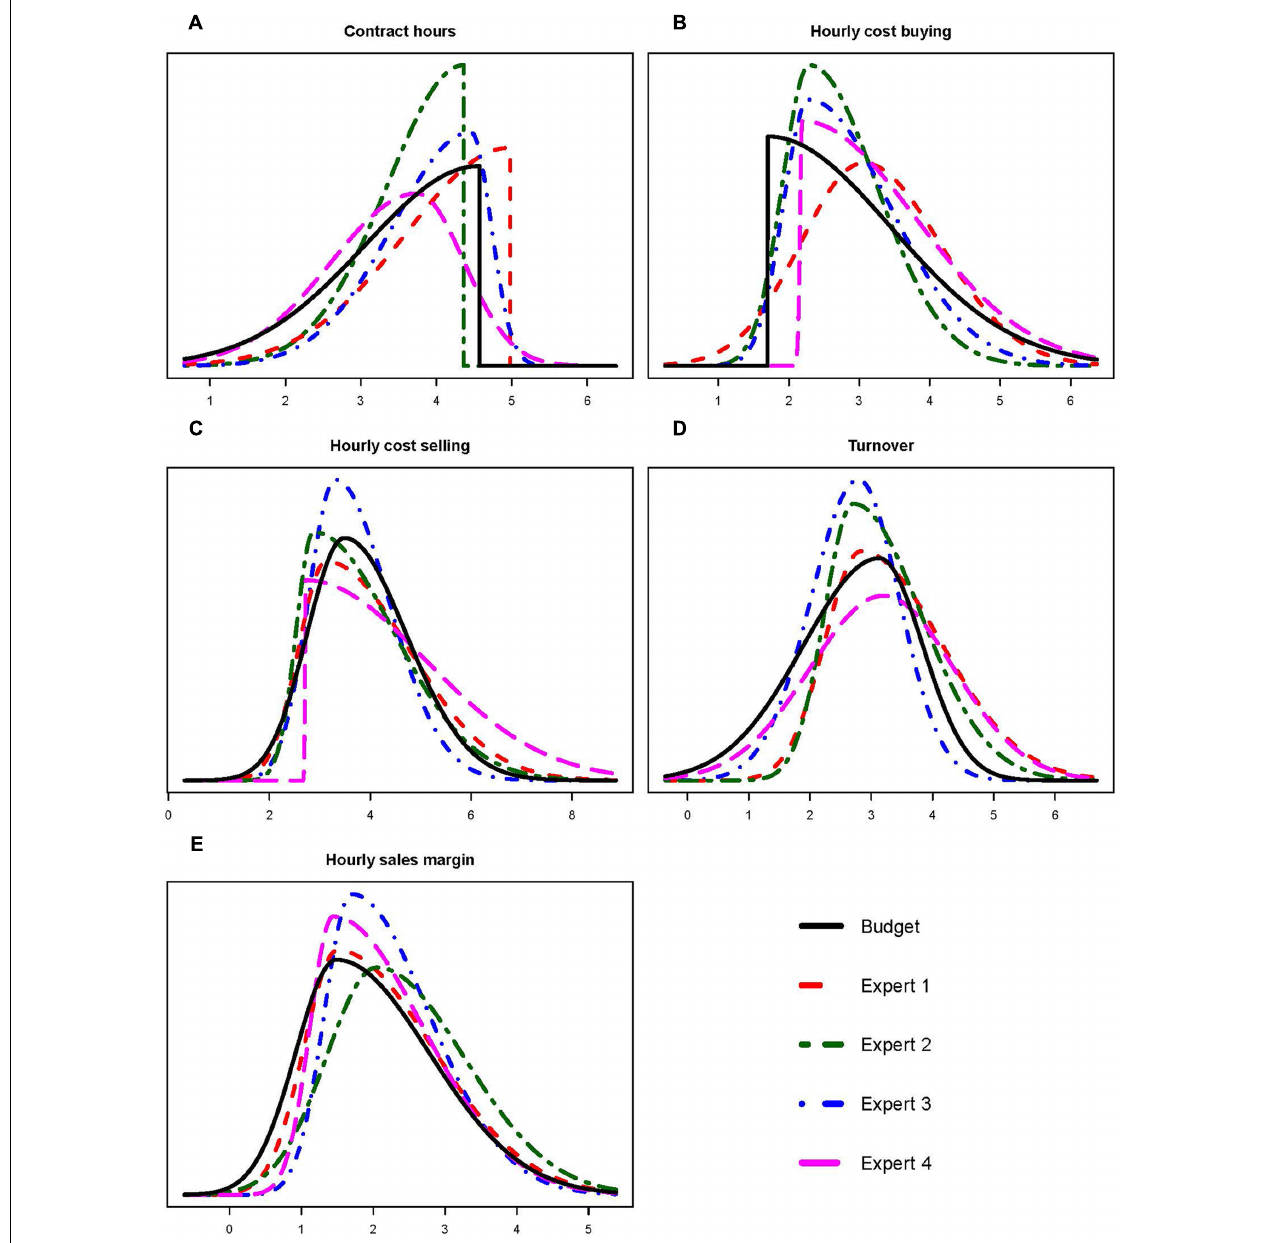
FIGURE 4 | Results for elicitation with the staffing company. Experts’ predictions plotted with actual budget for contract hours (A) , hourly cost buying (B) and selling (C) , turnover (D) and hourly sales margin (E) concerning the first quarter of